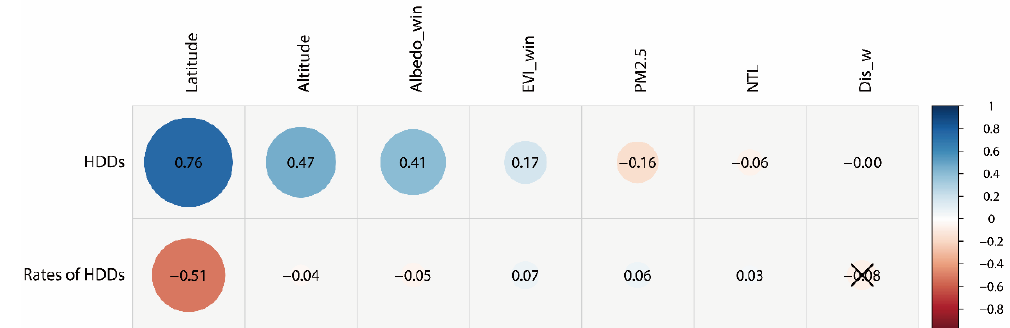
Figure 6. Partial correlation coefficients between the influence factors and heating degree days (HDDs) and their interannual change rates. The Albedo_win, Dis_w, EVI_win, PM 2.5 , and NTL corresponded to the mean albedo during winter, distance to large waterbodies (seas or oceans), mean EVI during winter, annual NTL intensity, and annual mean PM 2.5 concentration, respectively. The “×” indicates that no significant partial correlation existed ( p > 0.05).